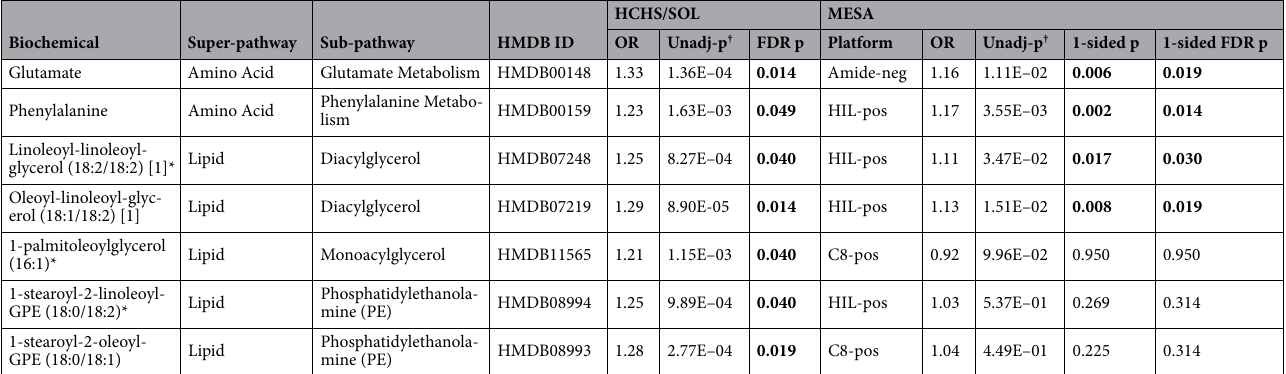
Table 2. Single metabolite associations with FDR-adjusted p -value < 0.05 in the discovery step. *Metabolite with * indicates they were identified based on accurate mass data, retention time and mass spectrometry but not reference standards. Therefore, the verification is not as robust as metabolites without *. † All results were adjusted for age, gender, BMI, study center, and Hispanic/Latino background in HCHS/SOL, and adjusted for age, gender, BMI, study site (site WFU and UCLA are combined due to low cell count), and race in MESA. Unadj- p is the abbreviations of raw p before the FDR correction. 1-sided p-values reflect the requirement of the same direction of associations in the discovery and validation datasets for concluding replication. Significant values are in bold.